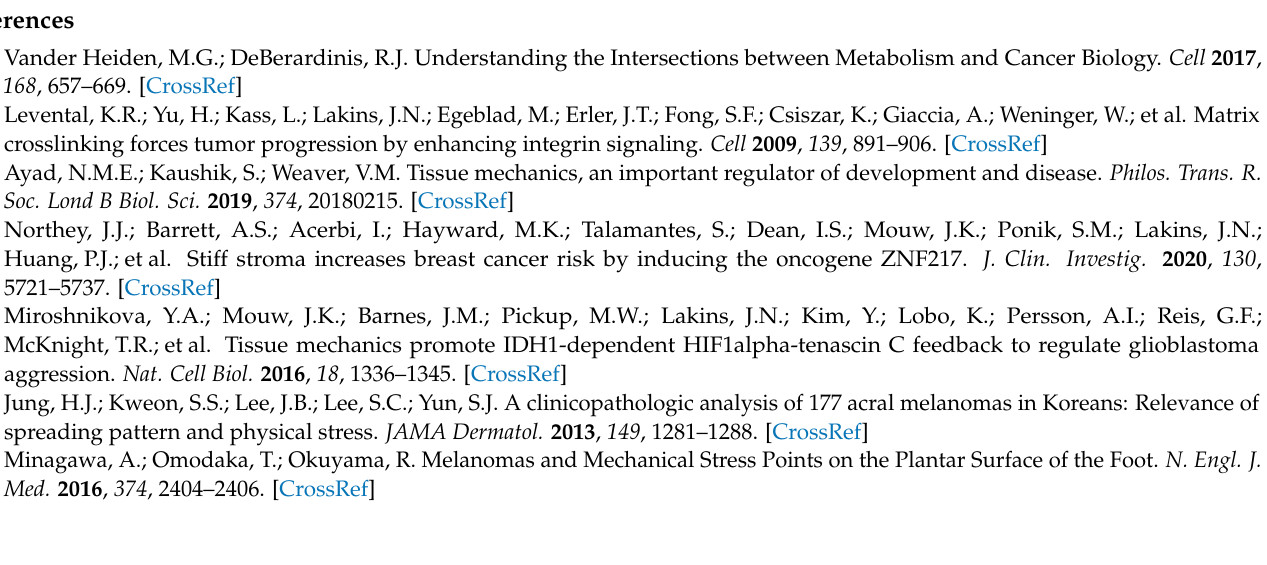
Table S1: YAP protein expression lever and expressing pattern diversities observed in patients; Table S2: YAP gene copy number diversities observed in